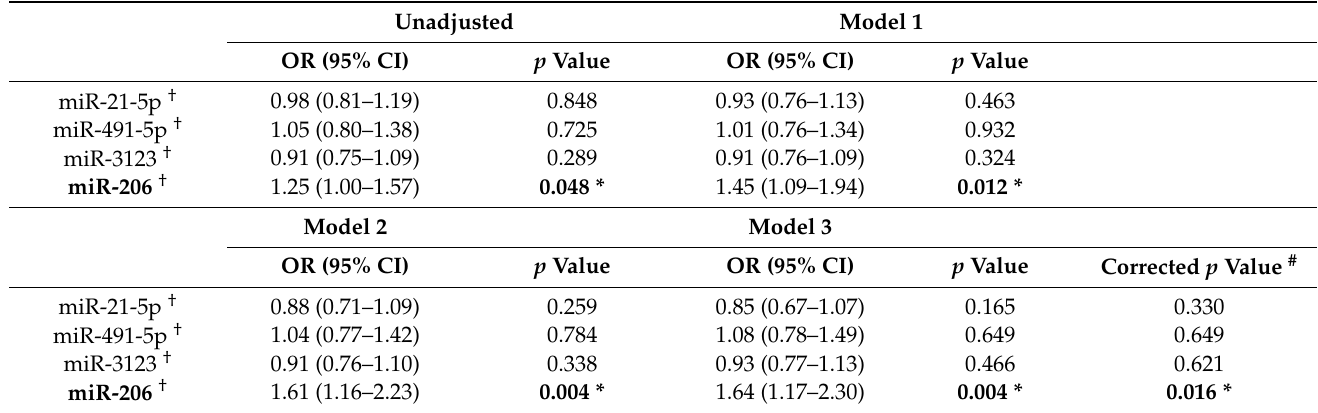
Table 3. Unadjusted and adjusted odds ratios of miRNAs expression for HT.